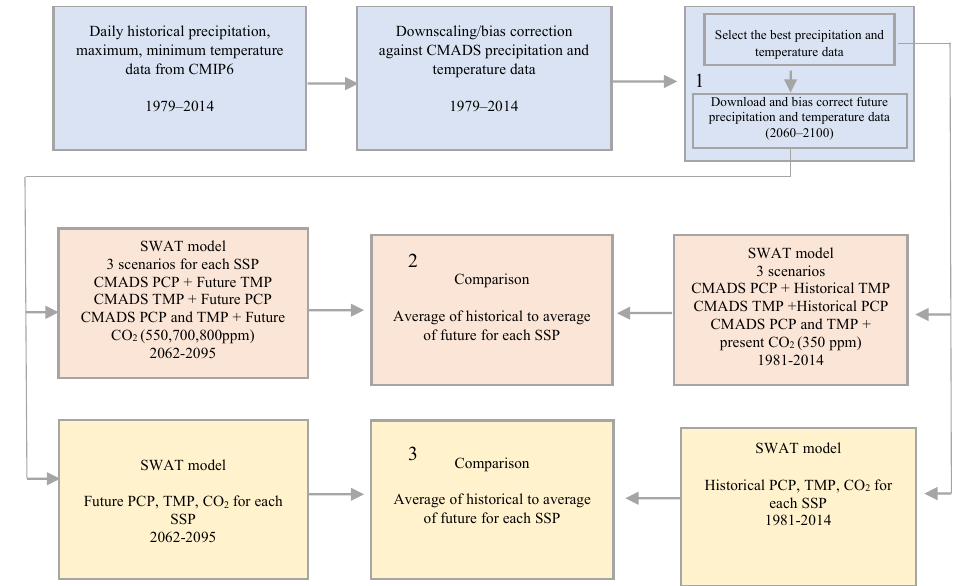
Figure 2. Workflow diagram of the evaluation of the impacts of future climate change.